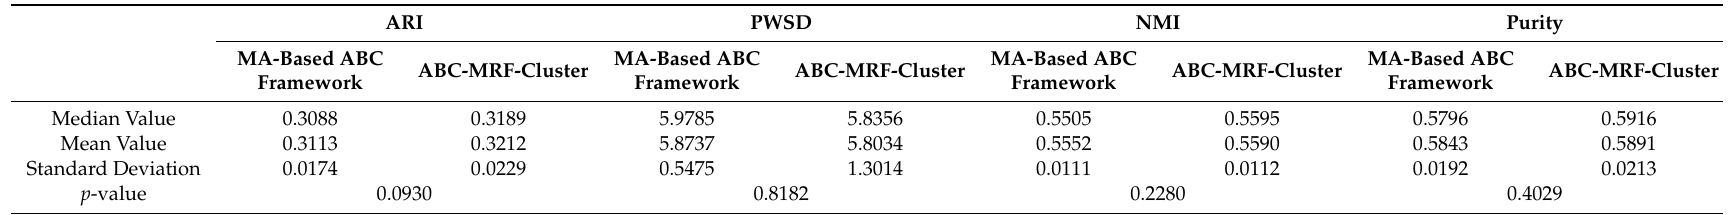
Table 5. Accuracy Statistics of the multiagent (MA)-based ABC Framework and the ABC-MRF-cluster in [5] for Dataset 1.